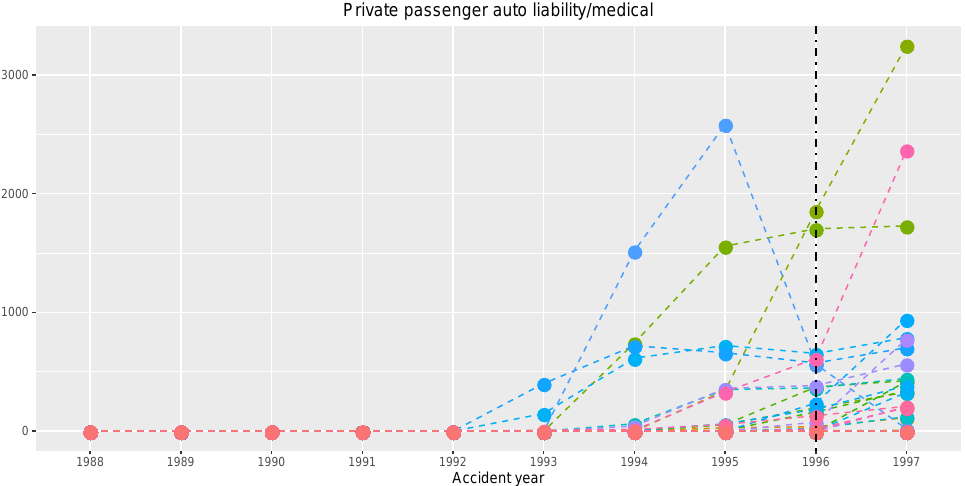
Figure 6. Development of the yearly total claim amounts normalized by the earned premium together with the estimated change point (cid:98) τ 146 = 9 (corresponding to year